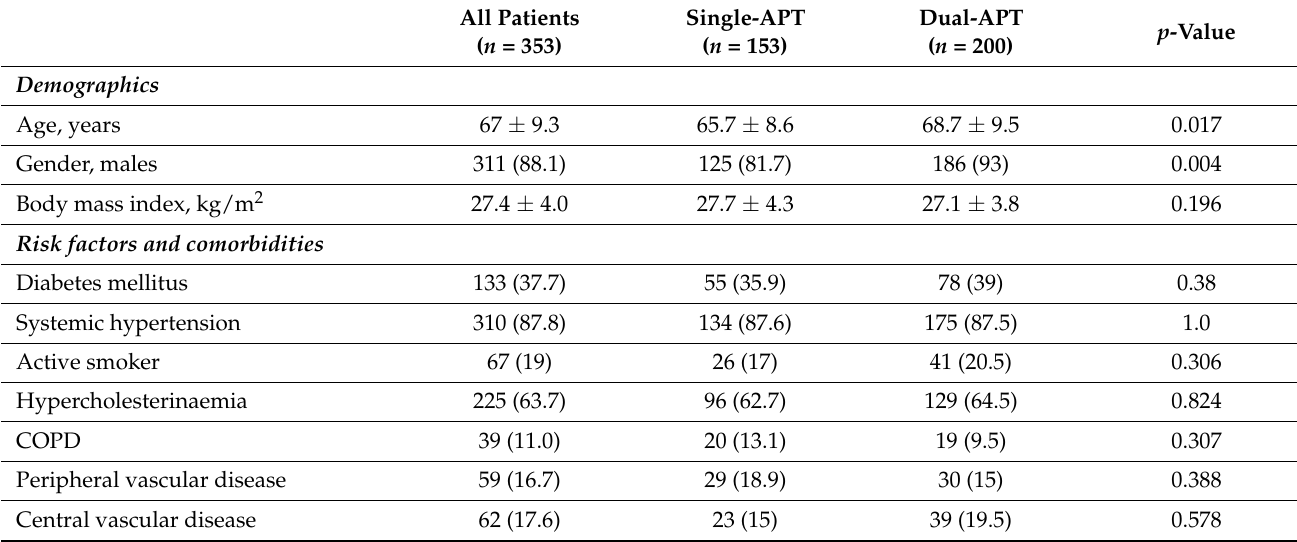
Table 1. Baseline demographic